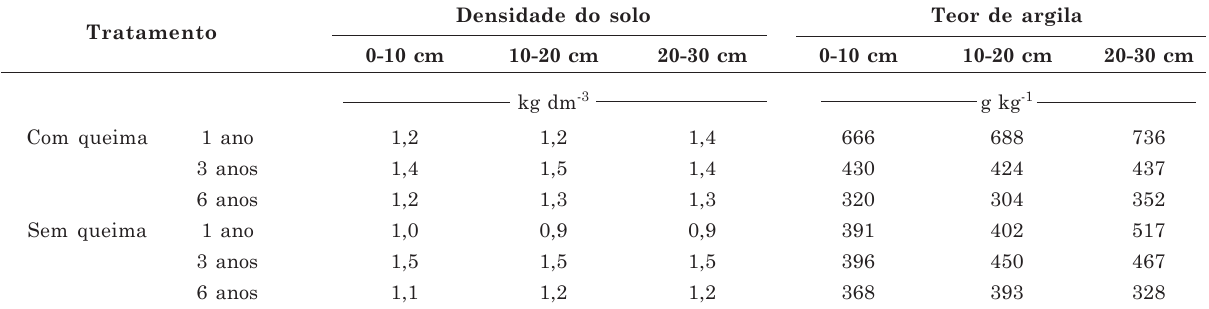
Quadro 2. Densidade do solo e teor de argila em cronossequências de cana-de-açúcar colhida com e